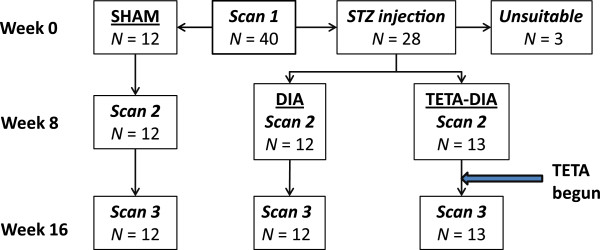
Flow chart illustrating the make-up and disposition of the study groups during the 16-week course of the in vivo part of this study.